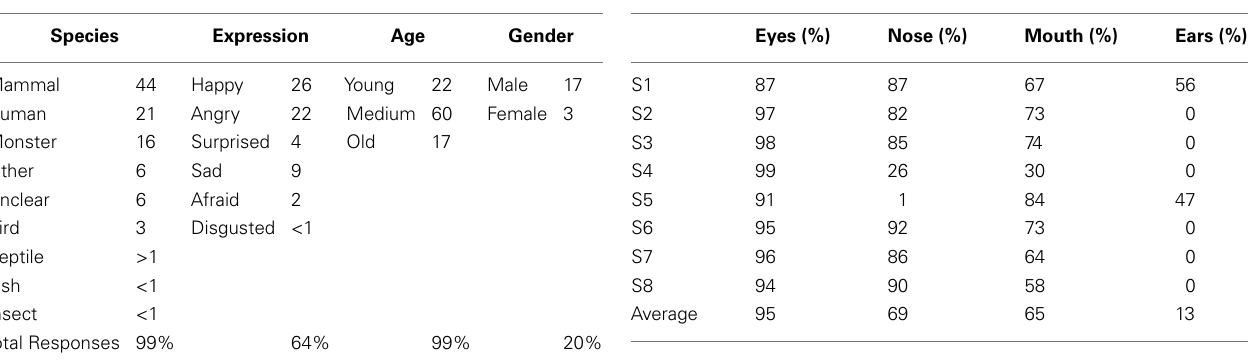
Table 2 | Detected features calculated as a percent of total faces reported for each